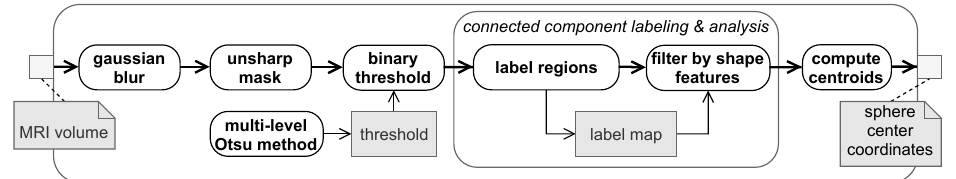
Figure 5. Pipeline for sphere detection based on connected component labeling and